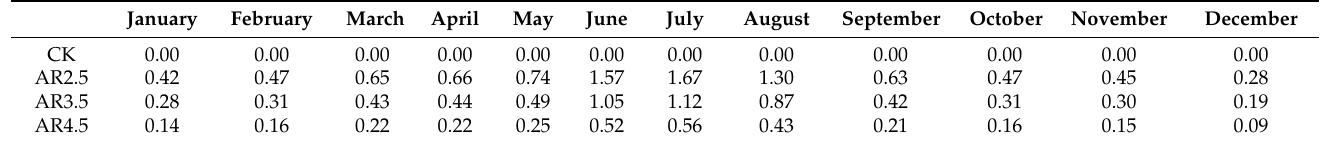
Figure A1. Correlation analysis of soil bacterial community structure characteristics and soil chemical properties. ** and * indicate significant difference at p < 0.01 and p < 0.05. TC: total organic carbon; TN: total nitrogen; C/N: total carbon/total nitrogen ratio; DOC: dissolved organic carbon; AN: alkali- Table A1. The contents of soil total N added to each plot under different treatments from December